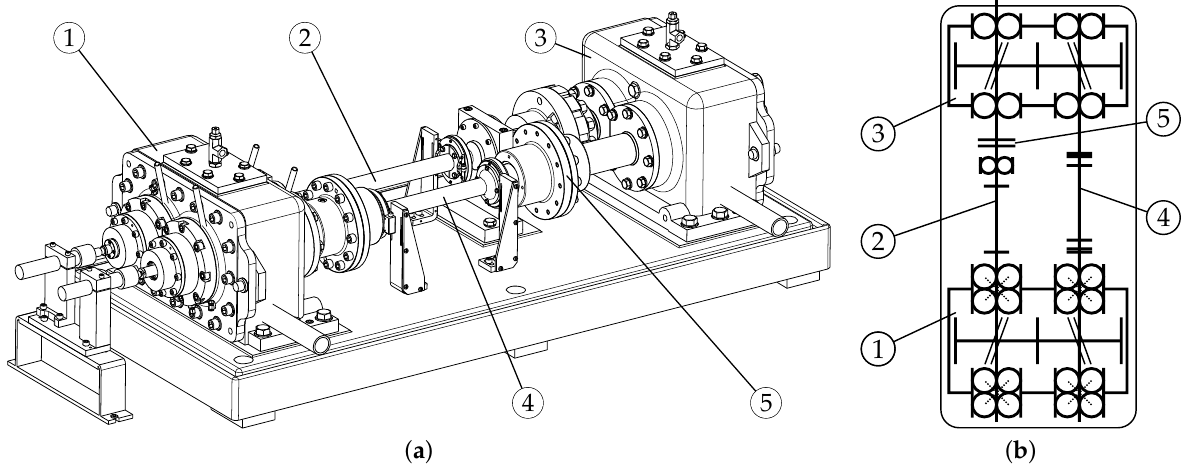
Figure 6. FZG dynamic test rig: 1-test gearbox, 2-pinion shaft, 3-drive gearbox, 4-wheel shaft, 5-loading clutch. ( a ) CAD view. ( b ) Principle